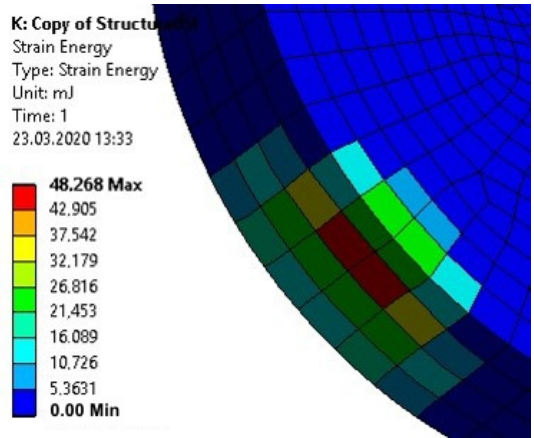
Figure 22. Energy of the plastic deformation of the upper element made of S235 steel loaded with 5000 N force.